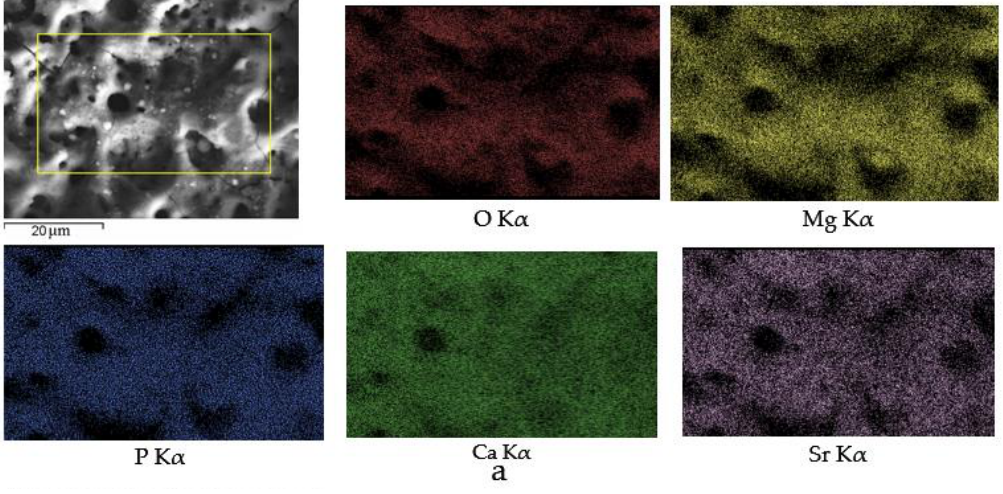
Figure 7. SEM image of the Sr-HA ( a ) and Sr-TCP ( b ) coatings deposited at 400 V; element distribution maps. Table 1. The elemental composition of the Sr-HA and Sr-TCP coatings on Mg0.8Ca determined by the EDX method in the region, (at.%).